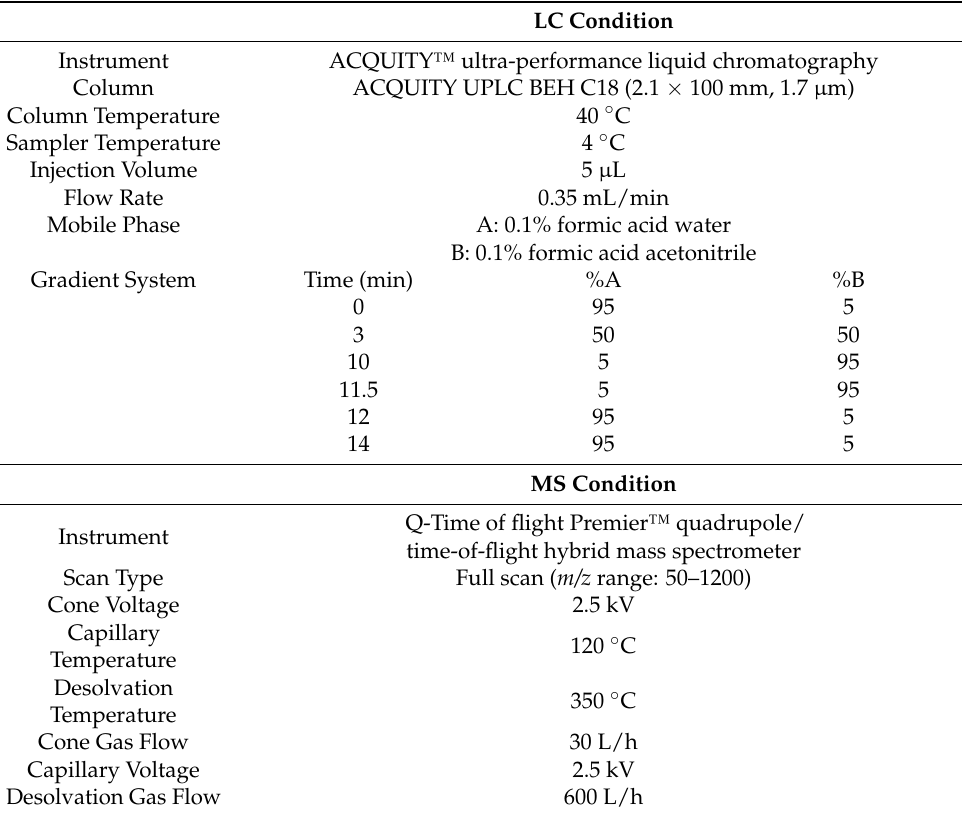
Table 3. Liquid chromatography-mass spectrometry instrumental